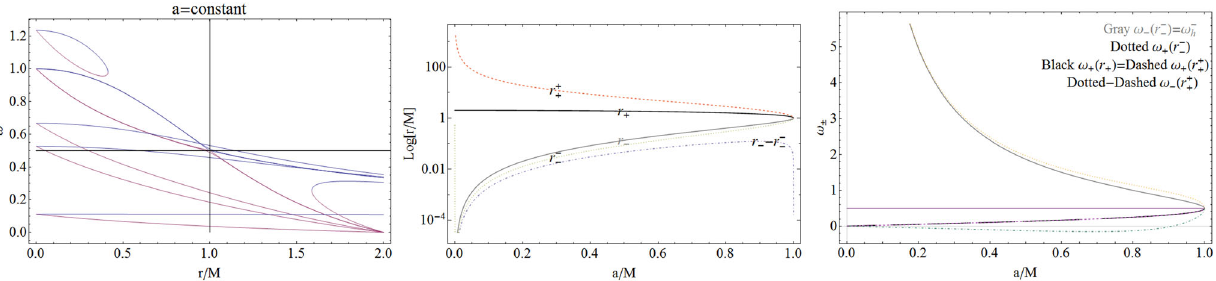
Figs. 2, 11, 27, 26 and 28, and center panel: killing horizons, r ± , and radii ( r − − , r + + ) as given in Eq. (13). Right panel: frequencies ω ± in r ± and ( r − − , r + + ) as functions of a /